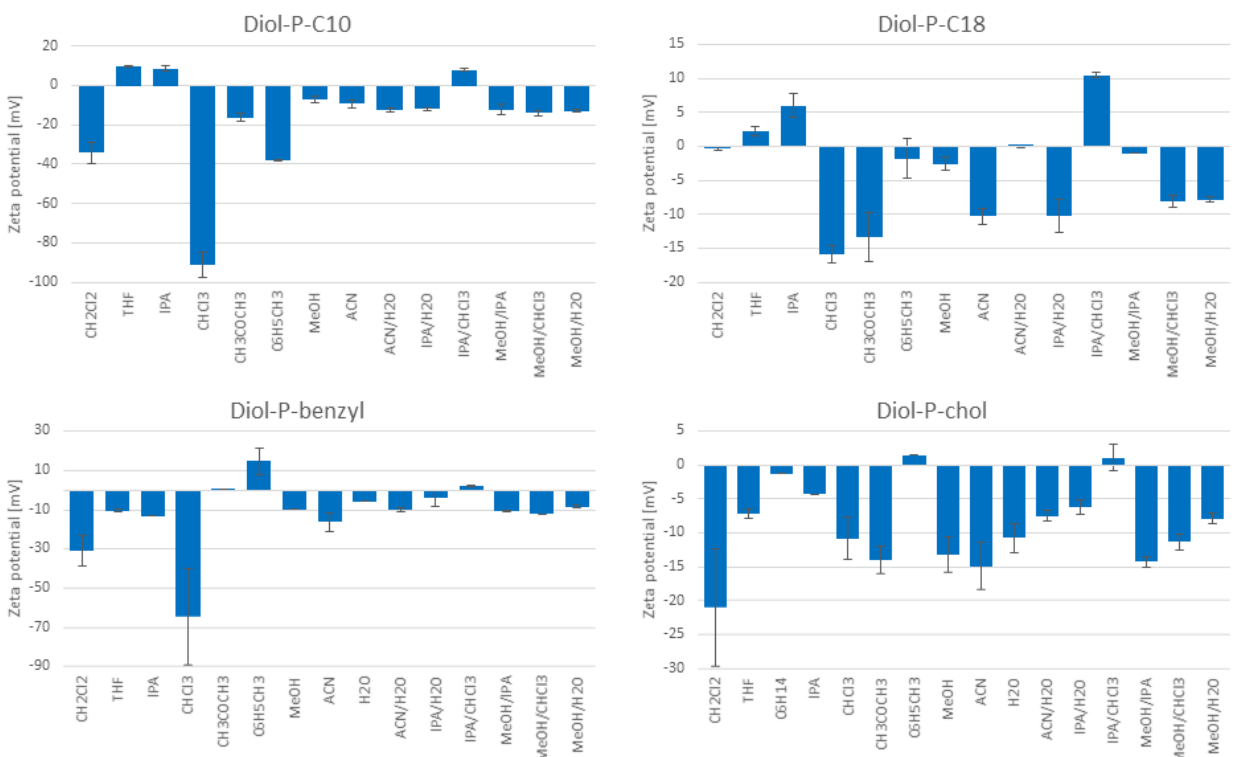
Figure 1. The zeta potential of stationary phases in different solvents with standard deviations [mV].